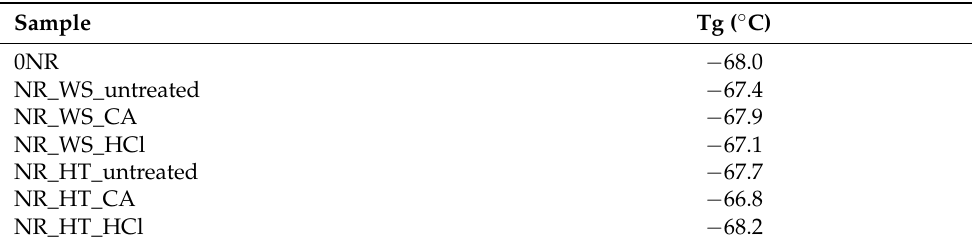
Table 7. Glass transition temperature of natural rubber vulcanizates filled with phyto-ash.